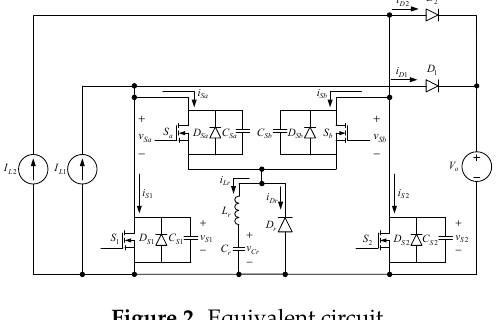
Figure 2. Equivalent circuit. Appl. Sci. 2019 , 9 , x FOR PEER REVIEW